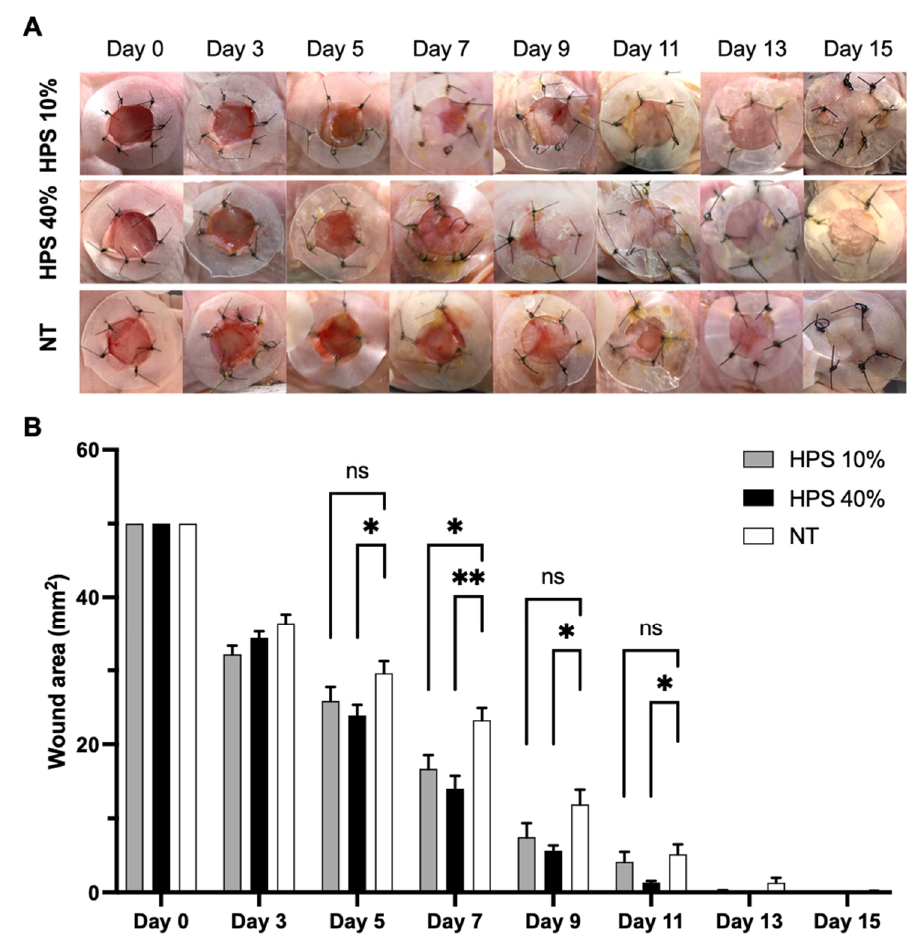
Figure 1. Accelerated wound healing in HPS-10% and 40% treated wounds. ( A ) Representative macroscopic photographs of full-thickness wounds in the excisional murine skin model on post- operative day (POD) 0, 3, 5, 7, 9, 11, 13 and 15. Two treatment groups were tested, HPS-10% ( n = 14) and HPS-40% ( n = 14) vs. no treatment (NT) ( n = 10). ( B ) Plot showing wound surface area (50 mm 2 wound area on POD 0) change from POD 0 to POD 15 in the HPS-10%/-40% and NT groups. HPS-40% group has smaller wound area compared to NT already at POD 5 and POD 7 ( p = 0.04 and p = 0.002 respectively), HPS 10% group has smaller wound area compared to NT at POD 7 ( p = 0.03). Wound healing kinetics of HPS-10% and -40% treatment groups showed to be significantly better than NT ( p = 0.02 and p = 0.0002, respectively). Two-way repeated measures ANOVA with Tukey’s multiple comparisons test. Data points represent means ± SEM. * = p < 0.05, ** = p < 0.01, ns = non- significant.